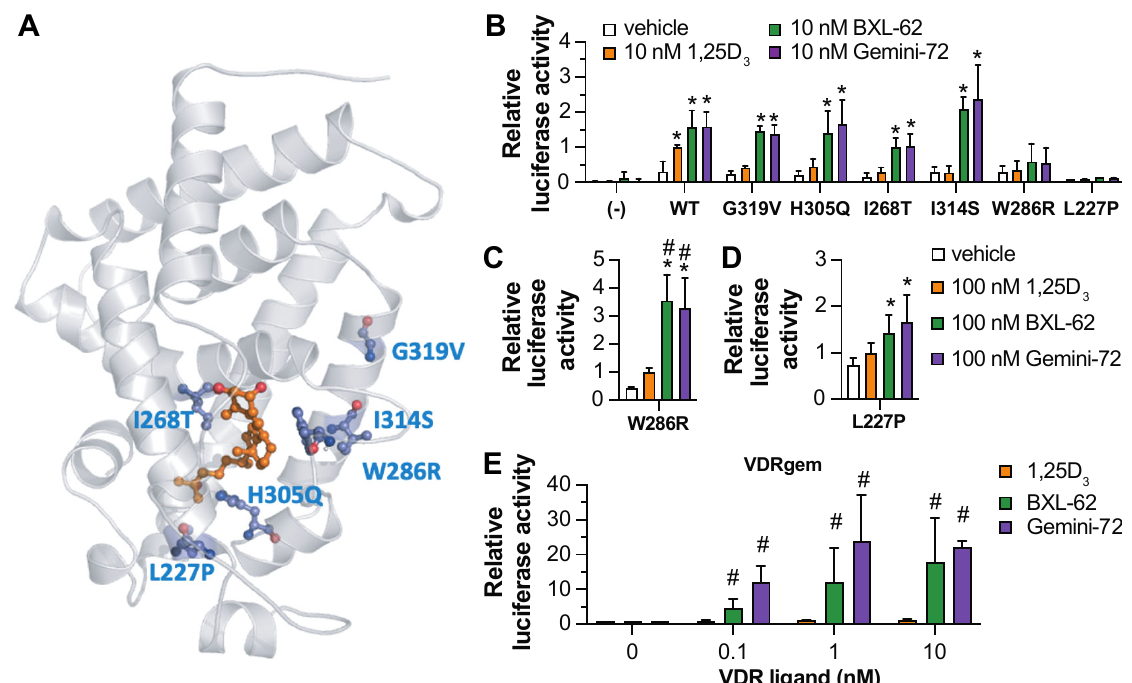
Figure 2. Transcriptional activity of point-mutated VDR. ( A ) VDR variants (in blue) identified in HVDRR patients mapped onto the hVDR LBD structure in the presence of 1,25D 3 (orange) (PDB 1DB1); ( B – E ) Relative activity of a reporter gene under the control of the promoter region of CYP24A1 in COS cells transiently transfected or not ( − ) with a VDR variant. Cells were treated for